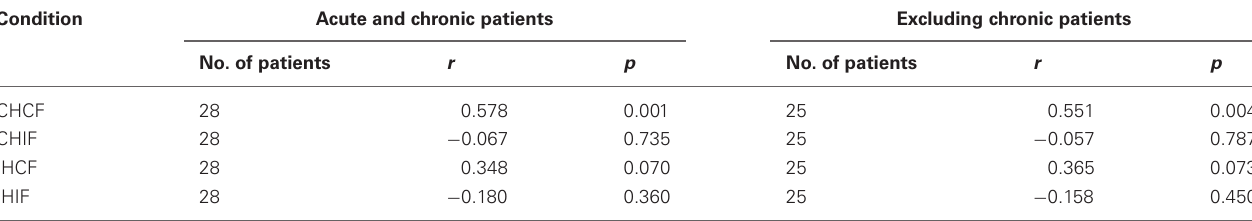
Table 6 | Results for the test-retest reliability. Condition